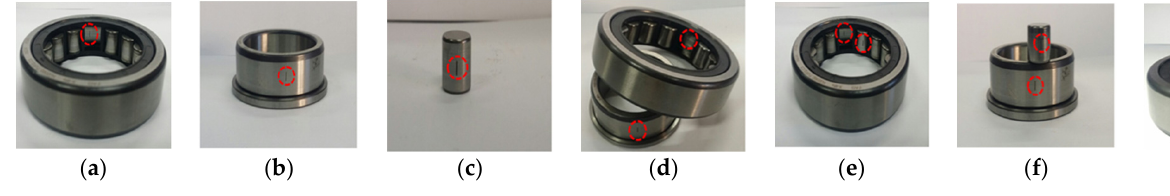
Figure 3. State of the bearing: ( a ) OC, ( b ) IC, ( c ) BC, ( d ) IOC, ( e ) IBC, ( f ) OBC and ( g ) IOBC.